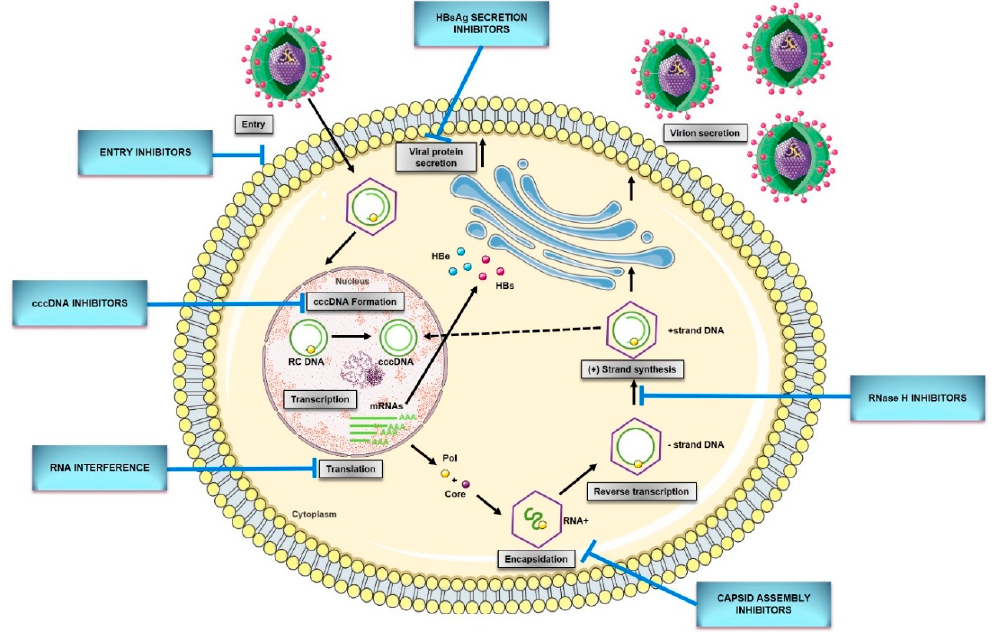
Figure 1. HBV replication cycle and new direct-acting antivirals for HBV. Entry: the replication cycle begins with the reversible binding of S-HBsAg to the glypican 5 (GPC5) protein [17], followed by specific binding between preS1 region of L-HBsAg and HBV entrance receptor—Sodium Taurocholate Cotransporting Peptide (NTCP) [18]. Upon the entrance, capsids are transported within the cytosol to the nucleus during which uncoating and release of the viral genome are initiated [14]. cccDNA formation : the molecular basis of rcDNA to cccDNA conversion remains unclear but it requires (1) the release of the viral polymerase covalently attached to the minus DNA strand by tyrosyl-DNA-phosphodiesterase 2 (TDP2) or its related proteins [19]; (2) the removal of the RNA primer from plus DNA strand by unrecognized enzymes; (3) cleavage of terminally redundant sequences (r) from the negative strand by structure-specific endonuclease 1 (FEN1) activity [20]; (4) the competition of positive DNA strand by the cellular replicative machinery: DNA polymerase κ [21] or polymerase α , δ , and ε [22], and DNA topoisomerase I and II [23]; (5) the ligation of both viral DNA strands by DNA ligase LIG I and LIG III [24]; (6) chromatinization involving histone chaperones, chromatin remodelers, transcription factors, and viral proteins [25]. Transcription and translation: cccDNA transcribes into all viral RNAs necessary for protein production and viral replication utilizing the cellular transcriptional machinery: 3.5-kb pregenomic RNA (pgRNA)/preC RNA and 2.4- kb, 2.1-kb, and 0.7-kb subgenomic RNA [15]. The pregenomic RNA encodes both the polymerase and core protein and works as a template for viral DNA replication. The three subgenomic RNAs encode envelope preS1 protein, preS2, and HBsAg proteins and the X protein [26]. The precore mRNA is translated into precore protein, which is processed at the N-terminal and C-terminal ends to HBeAg, a secretory protein. Pregenomic RNA is reverse transcribed into HBV DNA and also translated into core protein (HBcAg), which overlaps with HBeAg [27]. Encapsidation: the first step of HBV genome replication is the encapsidation of the pgRNA by core protein, forming an immature nucleocapsid. This process requires the cis-acting packaging signal (a stem-loop structure termed as epsilon, ‘ ε ’) at the 5 ′ end of pgRNA, and phosphorylation of C-terminal of the core protein [15]. Reverse transcription: tyrosine residue hydroxyl group of polymerase protein covalently binds at the ε region of 5 ′ pgRNA initiating the reverse transcription [14]. Next, the first three nucleotides from the bulge region of ε stem-loop are synthesized, and the polymerase with the covalently attached trinucleotide sequence translocates from ε to direct repeat, DR1 located at the 3 ′ -end of the 3.5-kb pregenomic RNA. Following the minus-strand elongation, pgRNA template is degraded by an RNase H encoded within the pol protein [28]. Pus-strand DNA synthesis: the terminal 16–18 nts from the 5 ′ end of pgRNA remains uncleaved and serves as the primer for plus-strand DNA synthesis after it translocates to a complementary sequence on the minus-strand template [29]. Circularization then occurs, facilitated